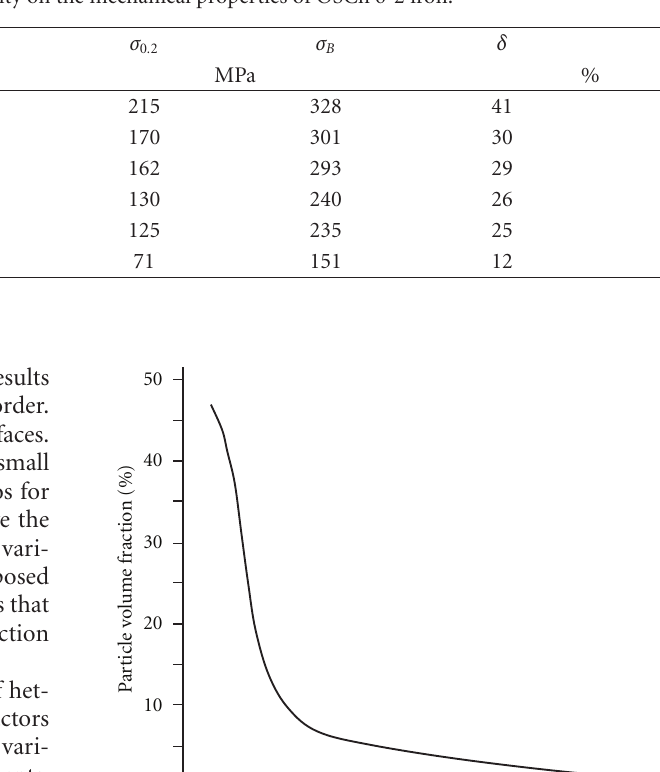
Table 2: The dependence of porosity on the mechanical properties of OSCh 6-2 iron.